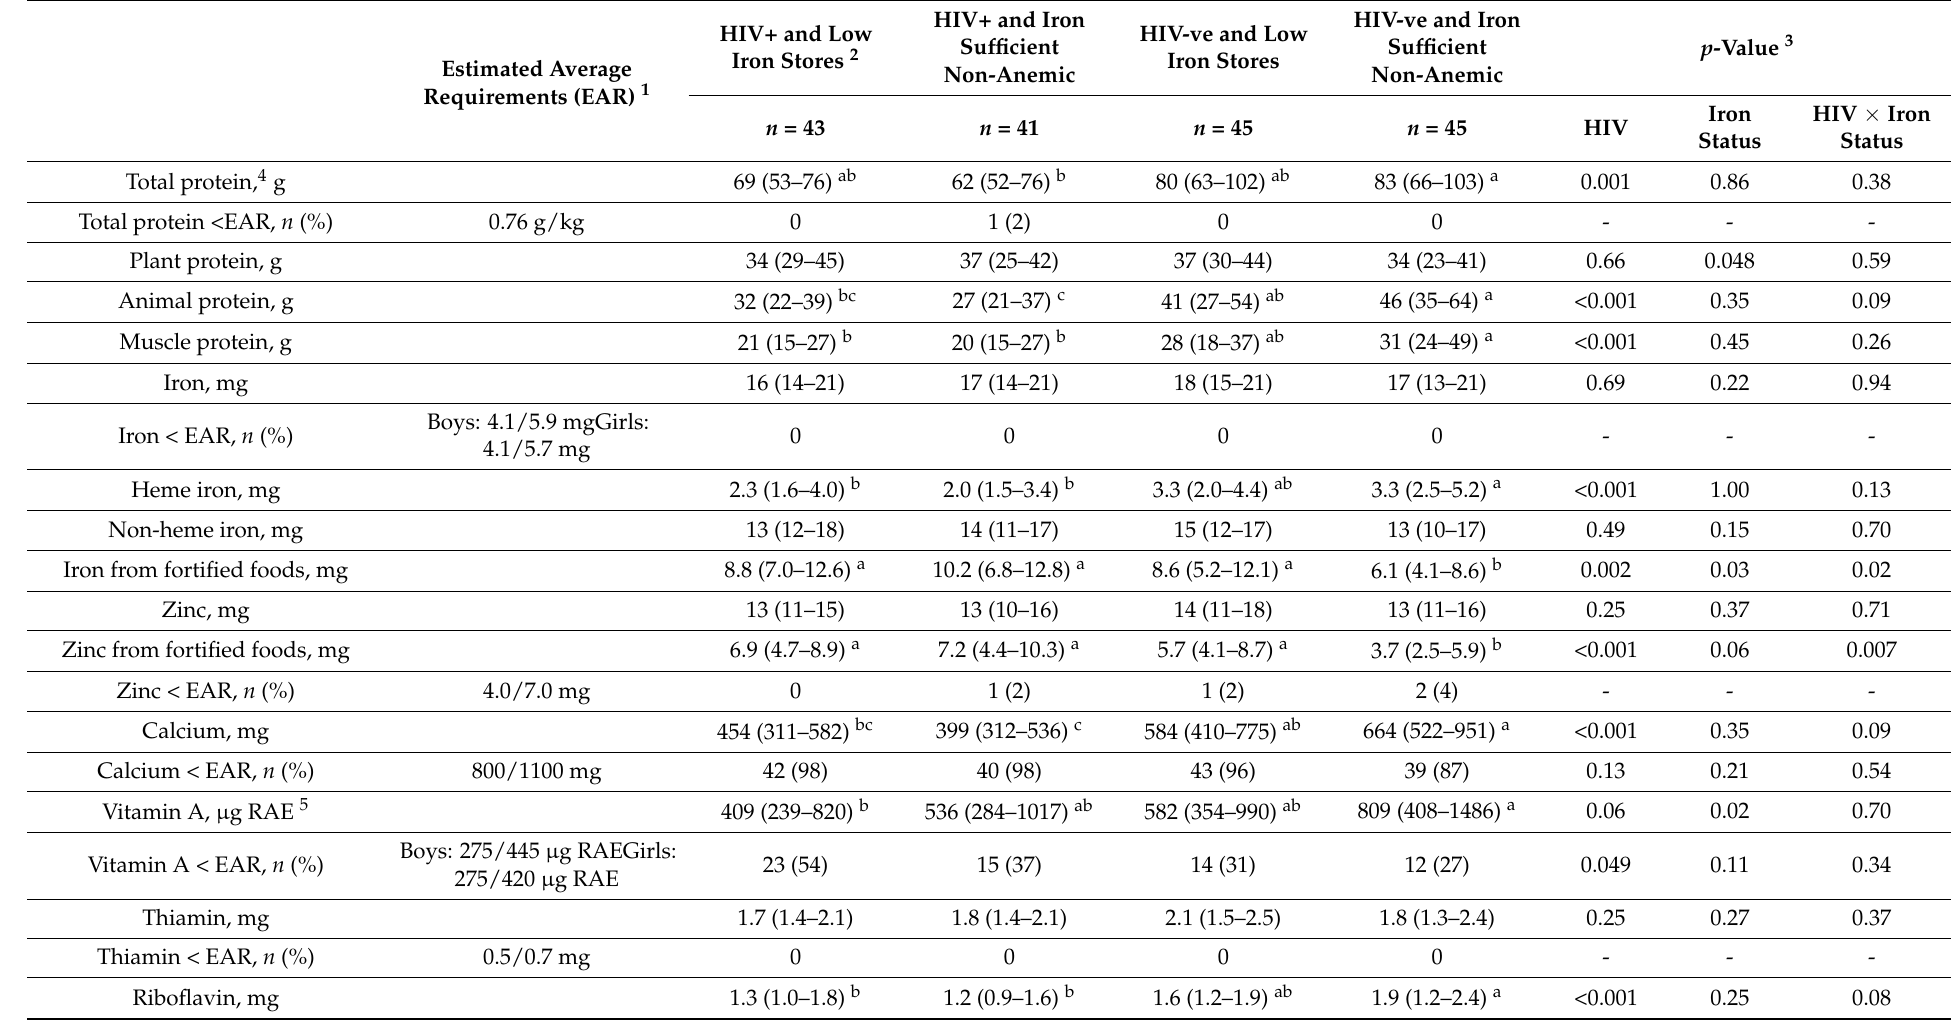
Table 5. Daily nutrient intake in the four groups of South African children purposefully selected according to HIV and iron